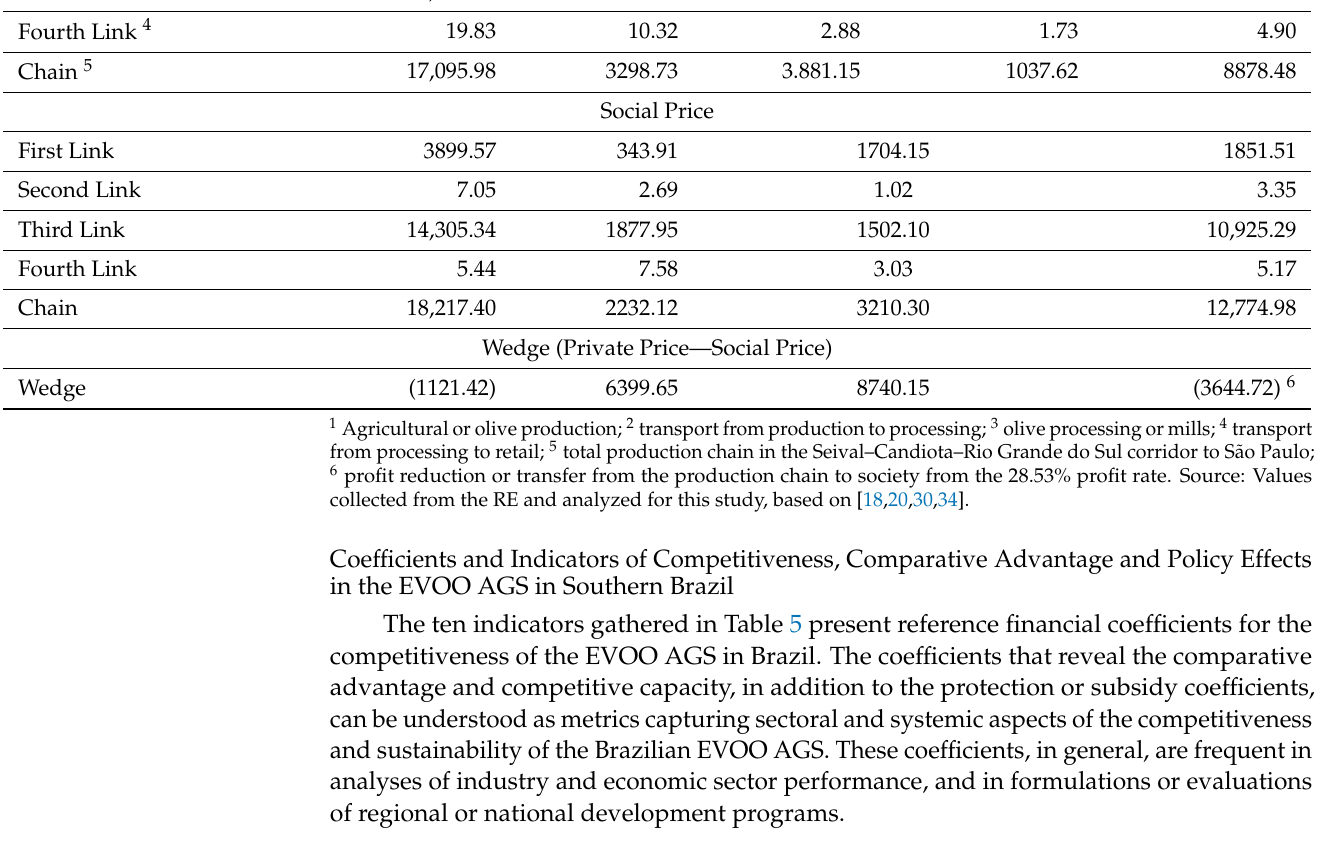
Table 5. Competitiveness coefficients and effects of policies on the EVOO AGS in southern